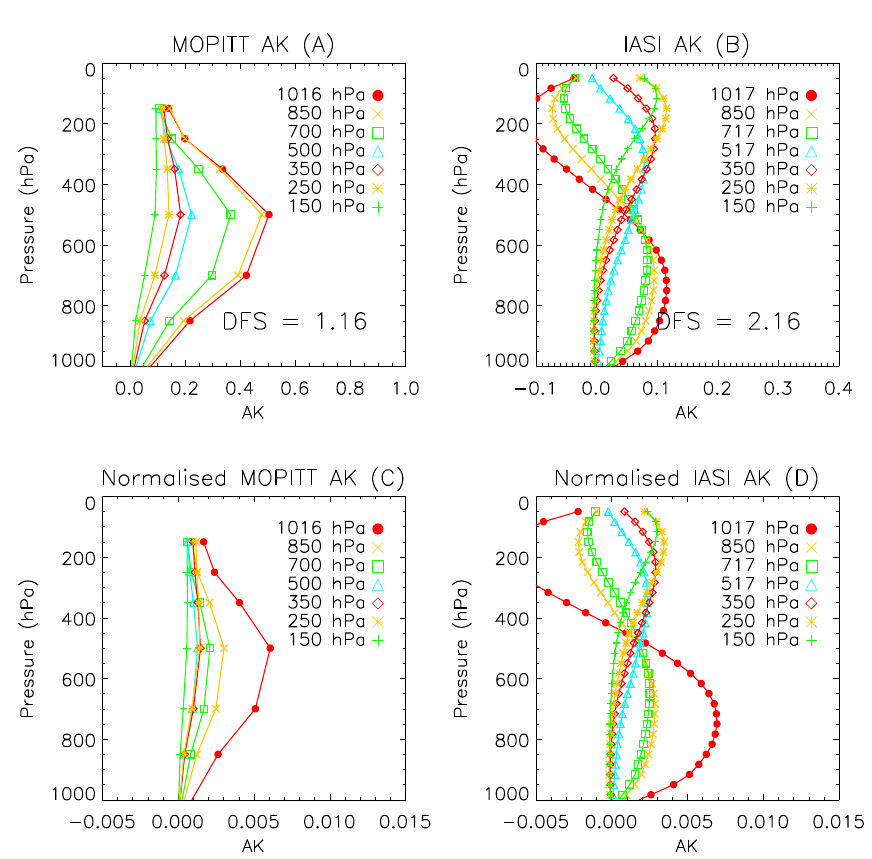
Fig. 5. Daytime and ocean averaging kernels over the Southern Africa region for 1 September 2007, for: (A) MOPITT V3 ( A MOP3 ) at MOPITT V3 pressure levels, (B) IASI ( A IASI ) at the IASI pressure levels closest to the MOPITT V3 pressure levels, (C) pressure-layer- normalised averaging kernels for MOPITT V3 ( A MOP3 ), and (D) pressure-layer-normalised averaging kernels for IASI ( A IASI N the pressure-layer-normalised averaging kernels are hPa − 1 .